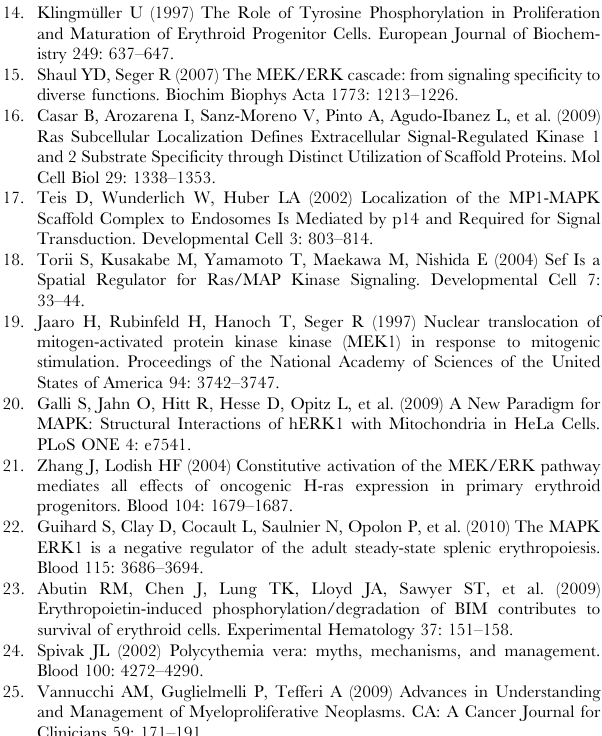
Figure S3 Increased intracellular citrate in FA-treated cells. CD34 + cells were cultured in erythroid medium for 5 days 6 50 m M FA. Cellular extracts were assayed for citrate levels enzymatically. Data are presented as mean fold increase over control cells 6 SD; n= 4; { P , 0.01. Figure S4 Aconitase inhibition does not prevent ERK dimerization. Detection of ERK2 dimer formation upon EGF stimulation by native gel electrophoresis followed by immunoblot- ting. HEK293T cells 6 500 m M FA, 6 10 m M U0126 were cytokine-starved overnight and stimulated with 100 ng/ml EGF for 5 minutes prior to harvest. Figure S5 Ba/F3 cells expressing EPOR or EPOR plus JAK2V617F are relatively resistant to the growth inhib- itory effects of FA. ( A ) Proliferation of Ba/F3 EPOR cells cultured in the presence of 2 ng/ml murine IL-3 and treated with 0–5 mM FA for 72 hours. Data are presented as mean 6 SD; n =3; * P , 0.05; n.s., not significant. ( B ) Proliferation of Ba/F3 EPOR JAK2V617F cells cultured as in panel A . Data are presented as mean 6 SD; n= 3; { P , 0.01. Figure S6 Paradoxical RSK deactivation in Ba/F3 EPOR JAK2V617F cells in response to EPO stimulation. Ba/F3 EPOR and Ba/F3 EPOR JAK2V617F cells were starved of cytokines for four hours prior to stimulation with 10 U/ml EPO for ten minutes. Phosphorylation of ERK and RSK was assessed by immunoblotting of whole cell lysates. Figure S7 Mice lacking cytosolic aconitase respond normally to fluoroacetate infusion. ( A ) RBC and hematocrit